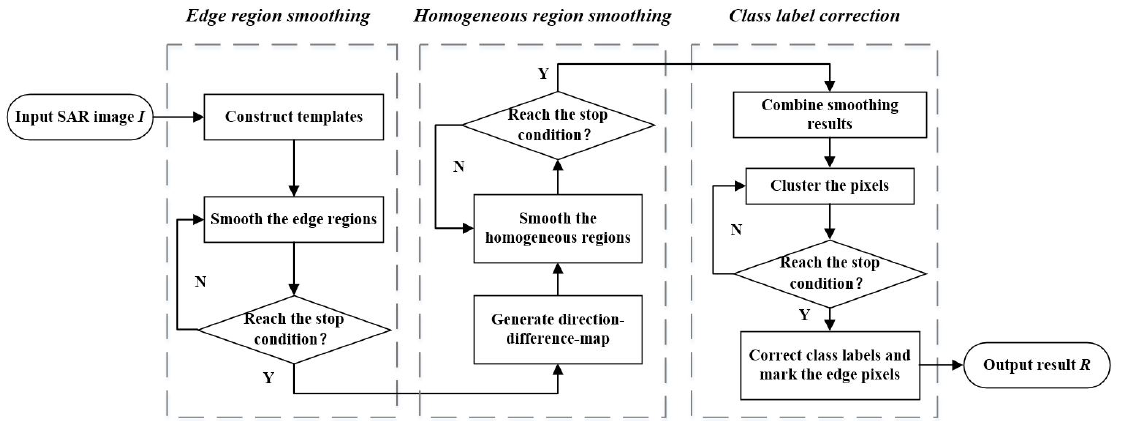
Figure 7. The flowchart of the proposed